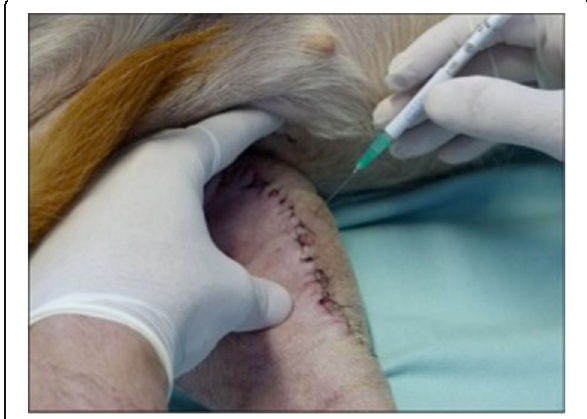
Fig. 1 Use of stem cells. Photograph in craniomedial view demonstrating percutaneous application of stem cells at the osteotomy site 8 days after the surgical